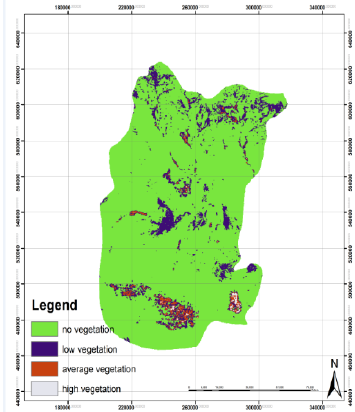
Figure 3. Vegetation classification map